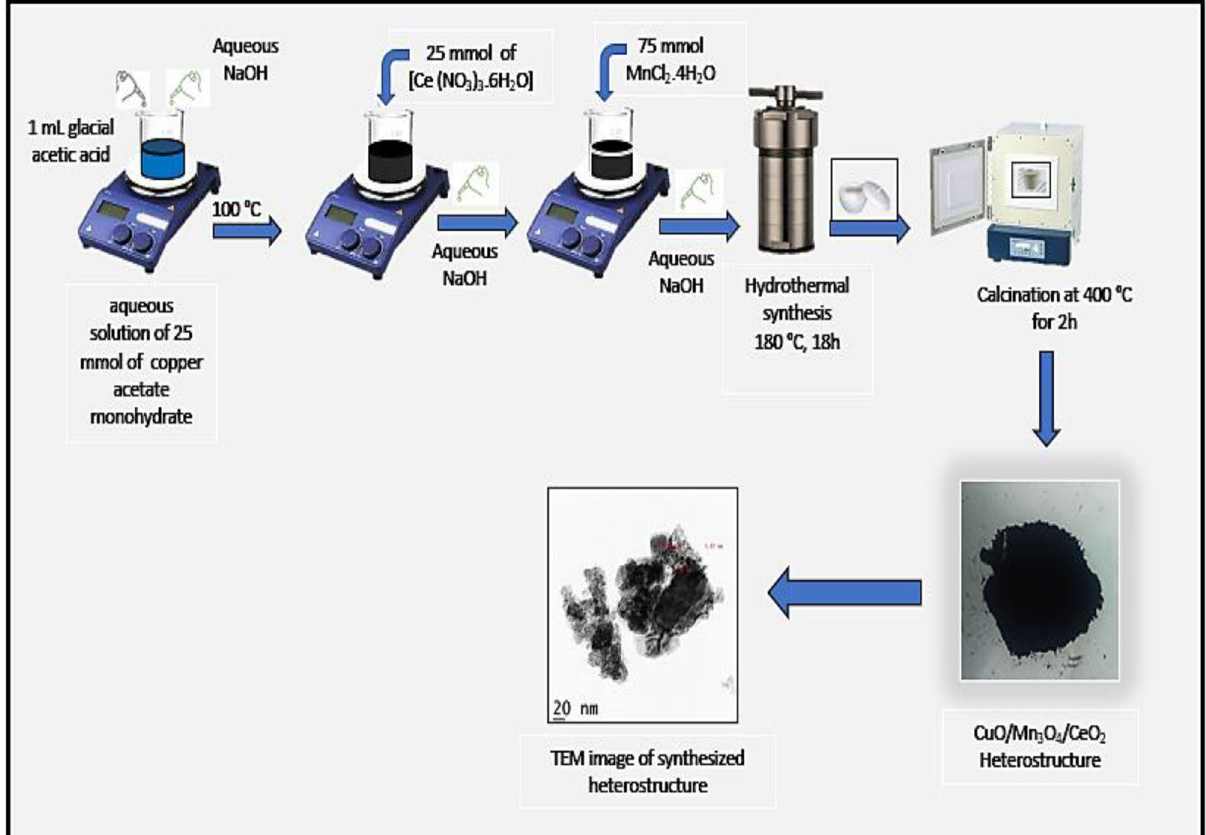
Figure 2. Schematic representation of the synthesis of CuO/CeO 2 /Mn 3 O 4